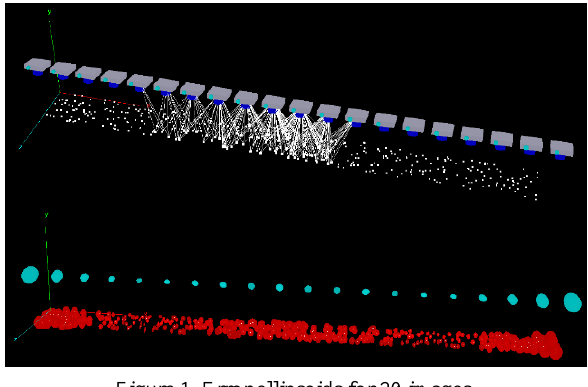
Figure 1. Error ellipsoids for 20 images.